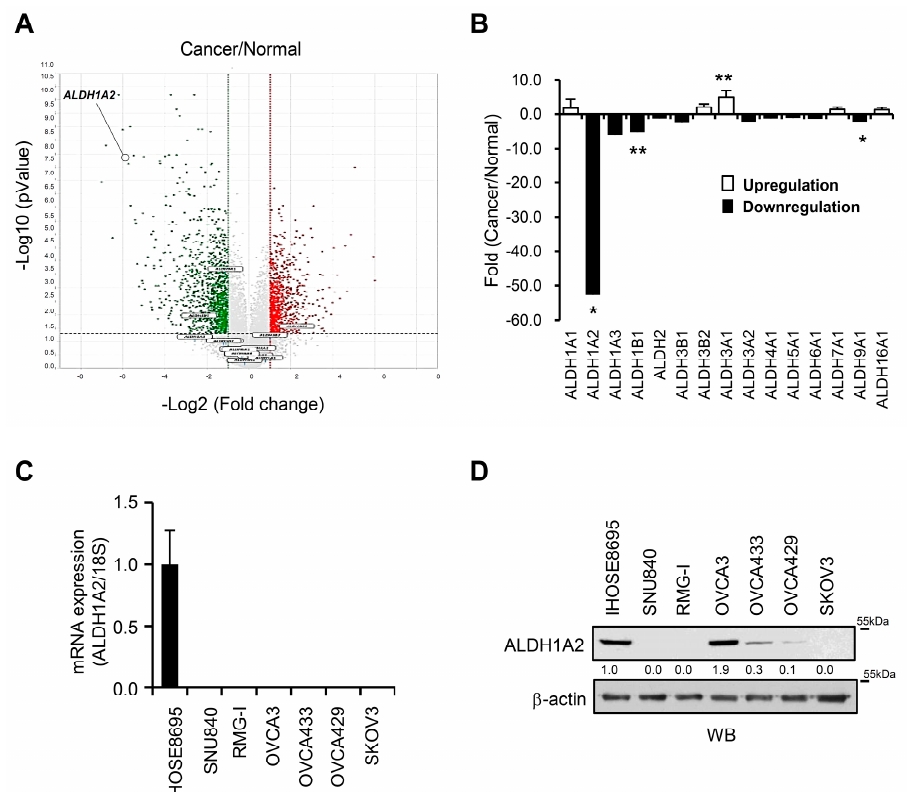
Figure 1. Comparative analysis of ALDH gene expression profiles and ALDH1A2 protein expression in ovarian cancer cell lines. ( A ) Volcano plot of the distribution of di ff erentially expressed genes between ovarian cancer cell lines (YDOV-139, YDOV-157, YDOV-161, YDOV-13, YDOV-105, and YDOV-151) and human ovarian surface epithelial (HOSE) cell lines (HOSE 198, 209, 211, and 213) using a DNA microarray. The volcano plot shows that 24,957 genes were di ff erentially expressed ( p < 0.01 and fold change > 2). The − log10 ( p -value) of each gene is plotted against the log 2 ratio of cancer intensity to normal intensity. Vertical dotted lines in red and green correspond to a 2.0-fold upregulation and 2.0-fold downregulation of expression, respectively. Horizontal black dotted lines indicate the significance level at p = 0.01. Plots were generated using ExDEGA v.1.6.5 software (Ebiogen, Seoul, Republic of Korea). ( B ) Up- and downregulation of gene expression were examined in six ovarian cancer cell lines (YDOV-139, YDOV-157, YDOV-161, YDOV-13, YDOV-105, and YDOV-151) and four HOSE cell lines (HOSE 198, 209, 211, and 213) using a DNA microarray. The values indicate fold changes in the expression levels of each gene in the ovarian cancer cell lines relative to those in the HOSE cell lines. Data are expressed as the means ± SD. Statistical significance was assessed using an unpaired t -test. * p < 0.001, ** p < 0.05. ( C ) Real-time PCR of the cDNA microarray results of ALDH1A2 in ovarian cancer cell lines and immortalized HOSE cells. The 18S rRNA gene was used as the endogenous control to normalize the data. ( D ) Immunoblotting analysis of ALDH1A2 expression in ovarian cancer cell lines and immortalized HOSE cells, with β‐ actin used as a loading control. The changes in the protein levels were estimated by quantification of band intensities with the ImageJ software. The protein levels were normalized to the signal of ‐ actin.